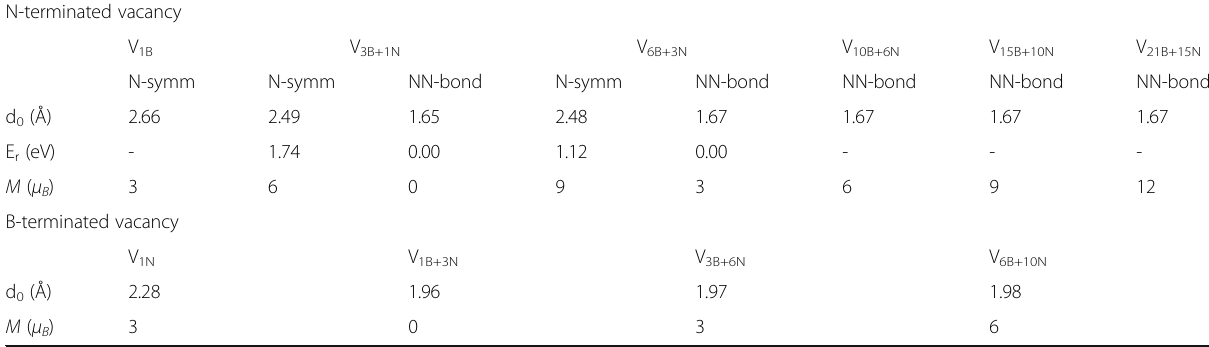
Table 1 The distances d 0 (Å) between N atoms (N-terminated vacancy) or B atoms (B-terminated vacancy) at vertices of vacancy structures, calculated total magnetic moments M ( μ B ), and the relative energies E r (eV) for triangular vacancy configurations of h -BN sheet